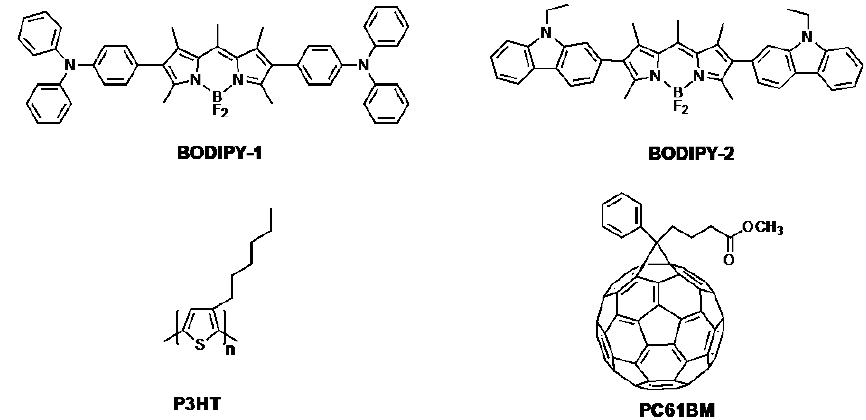
Figure 1. The corresponding chemical structures of boron dipyrromethene-1 ( BODIPY-1) , BODIPY-2 , poly-3-hexyl thiophene (P3HT), and (6,6)-phenyl-C61-butyric acid methyl ester (PC 61 BM) for use in ternary solar cells.